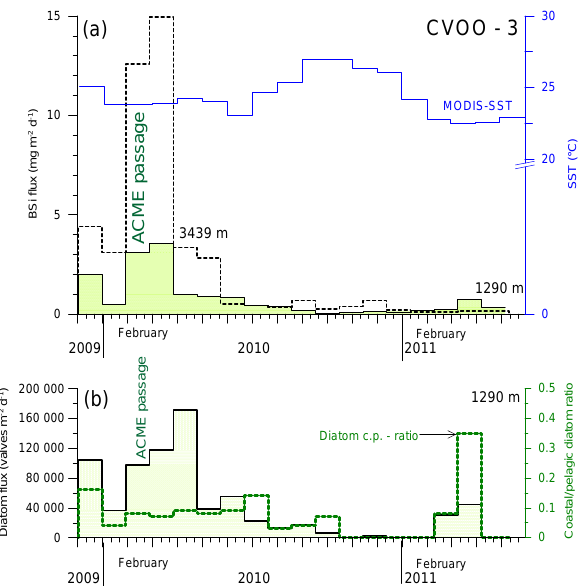
Figure 4. (a) BSi fluxes collected with the upper and lower sedi- ment traps at CVOO-3. During the ACME passage in winter 2010, BSi fluxes were more than 3 times higher in the lower trap. Fluxes in both depth levels were highly correlated ( r 2 = 0.9, N = 17). Monthly mean SST from MODIS-Terra-4km is shown for a 1 ◦ box to the east of the CVOO-3 site (17–18 ◦ N, 23–24 ◦ W). (b) Diatom fluxes and the coastal:pelagic diatom ratio are given for the upper trap